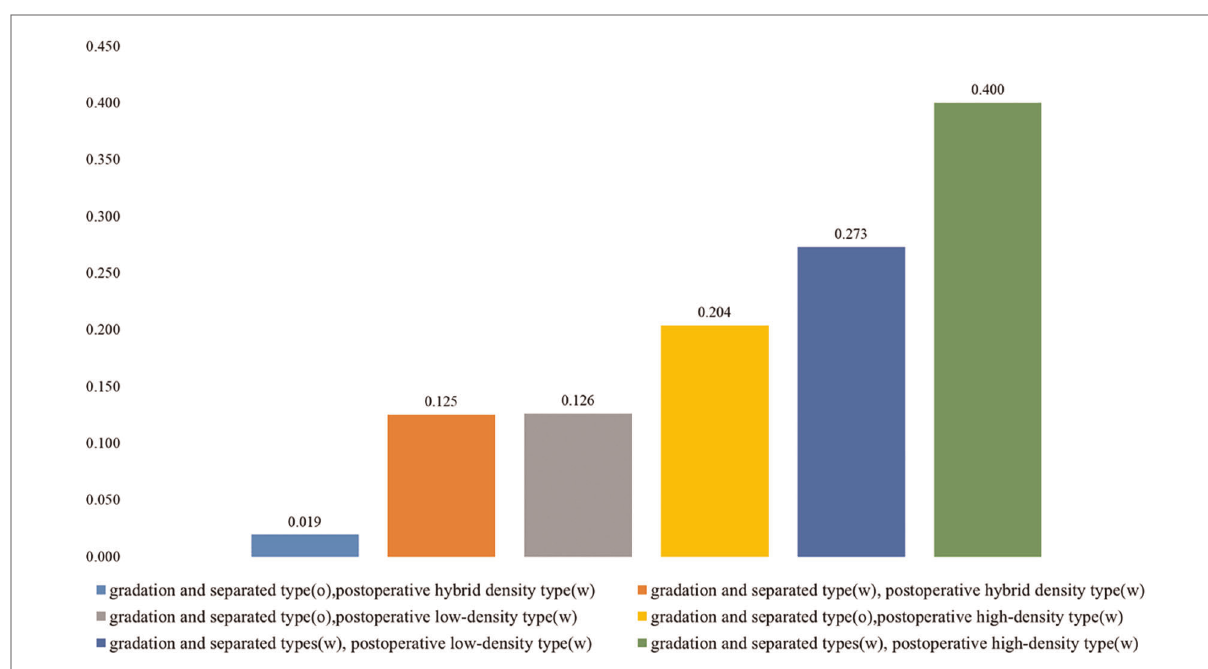
FIGURE 3 Recurrence rates (%) in patients with CSDH with or without gradation and separated types, postoperative hybrid-density type, postoperative low- density type, and/or postoperative high-density